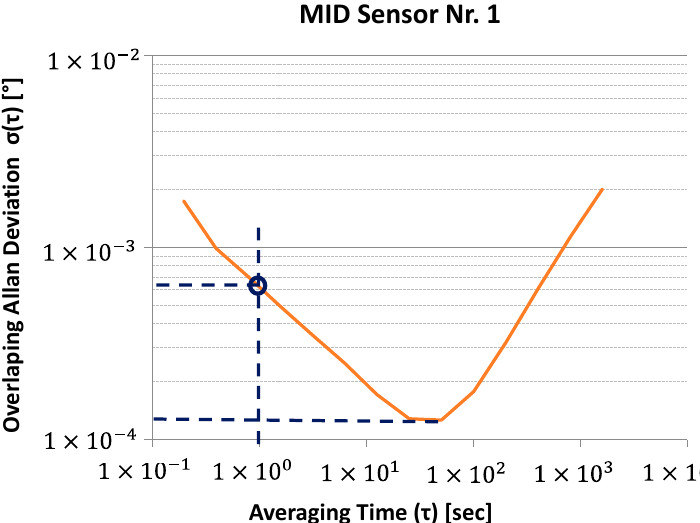
Figure 8. Allan deviation plot with random walk and bias stability.